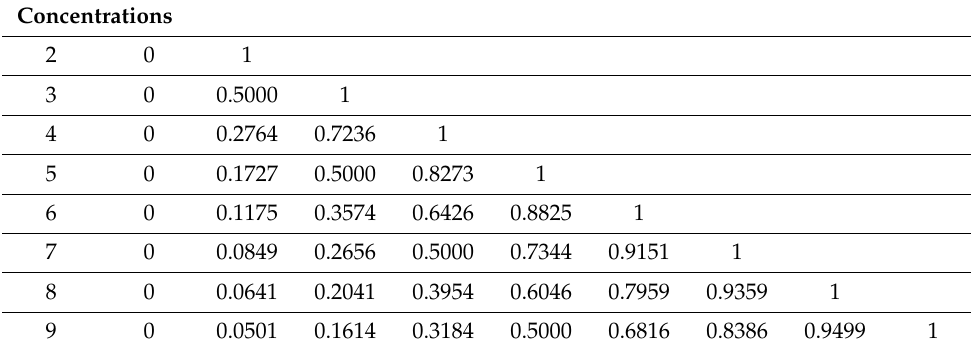
Table 1. D-optimal nonuniform designs for standardized interval